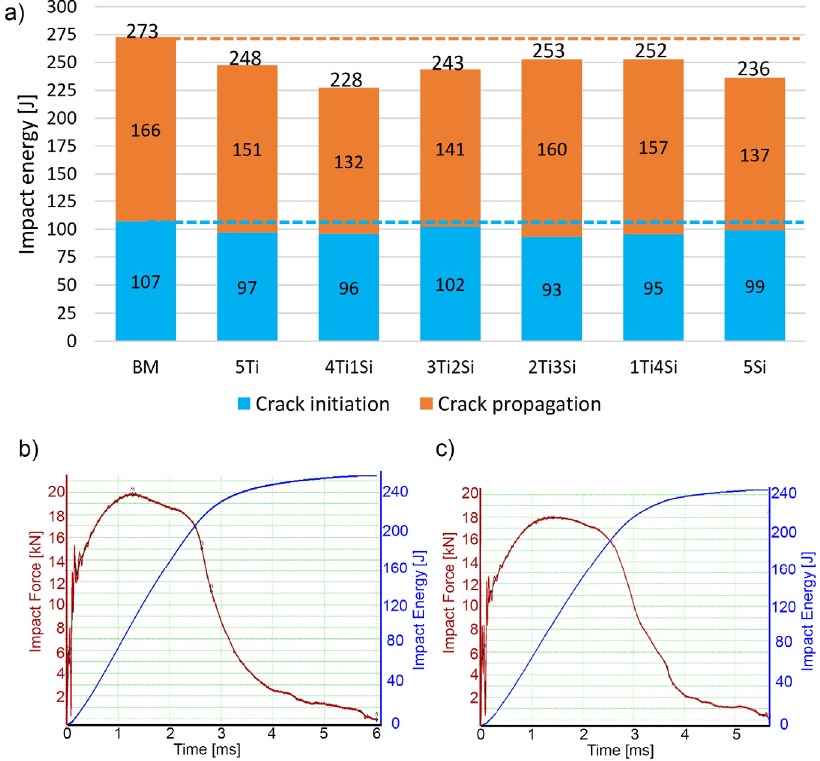
Figure 9. Impact energy of welded specimens: crack initiation, crack propagation, and overall impact energy ( a ); force–time curve of base metal ( b ); force–time curve of specimen 3Ti2Si ( c ) .